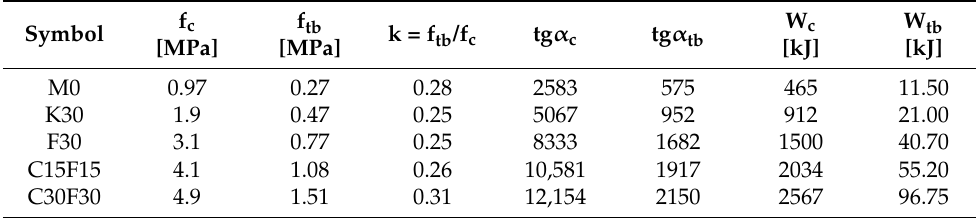
Table 4. Strength parameters of tested lime mortars.